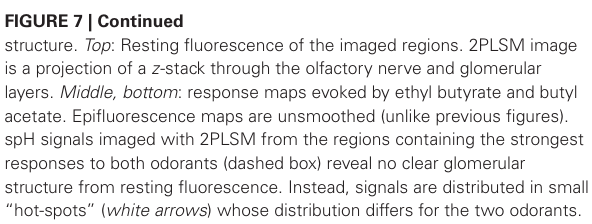
FIGURE 7 | Continued structure. Top : Resting fluorescence of the imaged regions. 2PLSM image is a projection of a z -stack through the olfactory nerve and glomerular layers. Middle, bottom : response maps evoked by ethyl butyrate and butyl acetate. Epifluorescence maps are unsmoothed (unlike previous figures). spH signals imaged with 2PLSM from the regions containing the strongest responses to both odorants (dashed box) reveal no clear glomerular structure from resting fluorescence. Instead, signals are distributed in small “hot-spots” ( white arrows ) whose distribution differs for the two